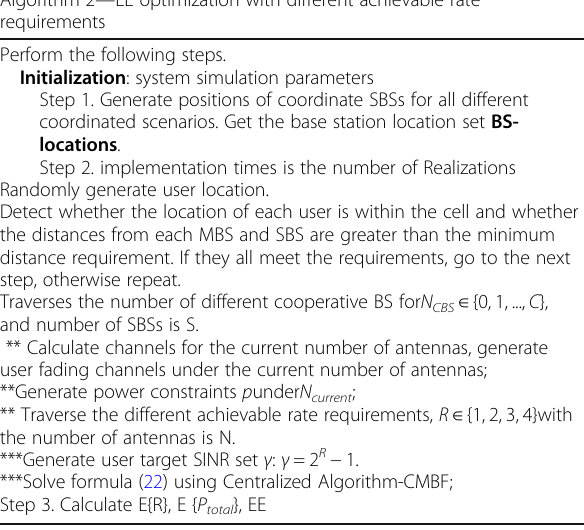
Table 3 EE optimization with different achievable rate requirements Algorithm 2 — EE optimization with different achievable rate requirements